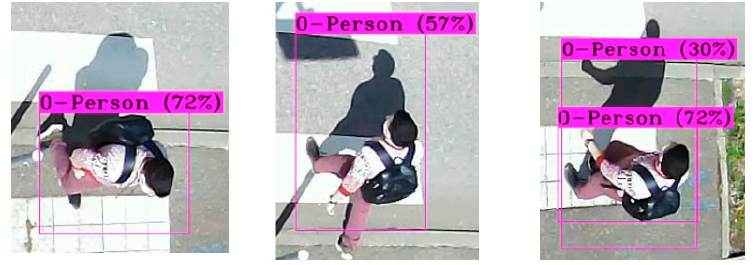
Figure 8. Inaccuracy of pedestrian detection in the presence of a shadow.